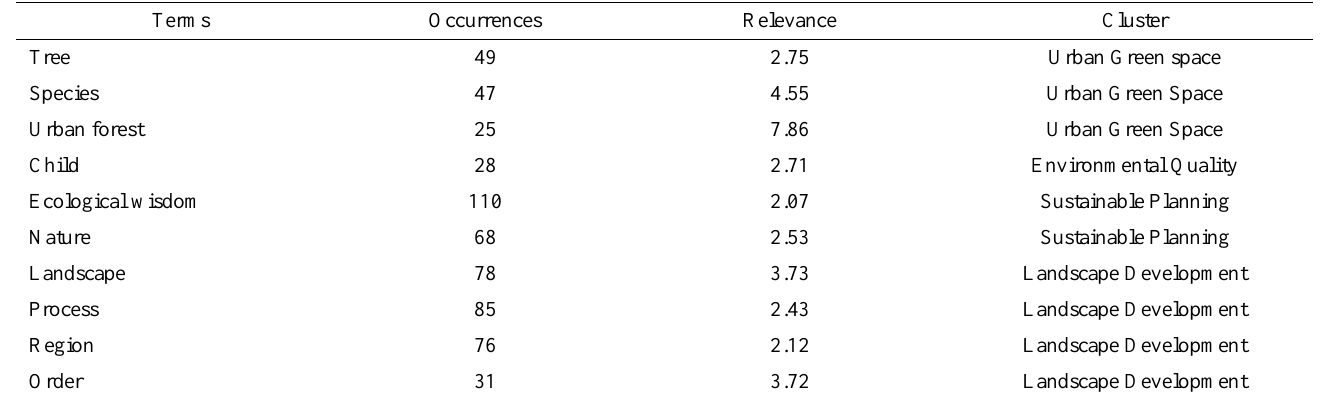
Table 2. The Highest Relevance Noun Phrase in Green Open Space and Ecological Wisdom